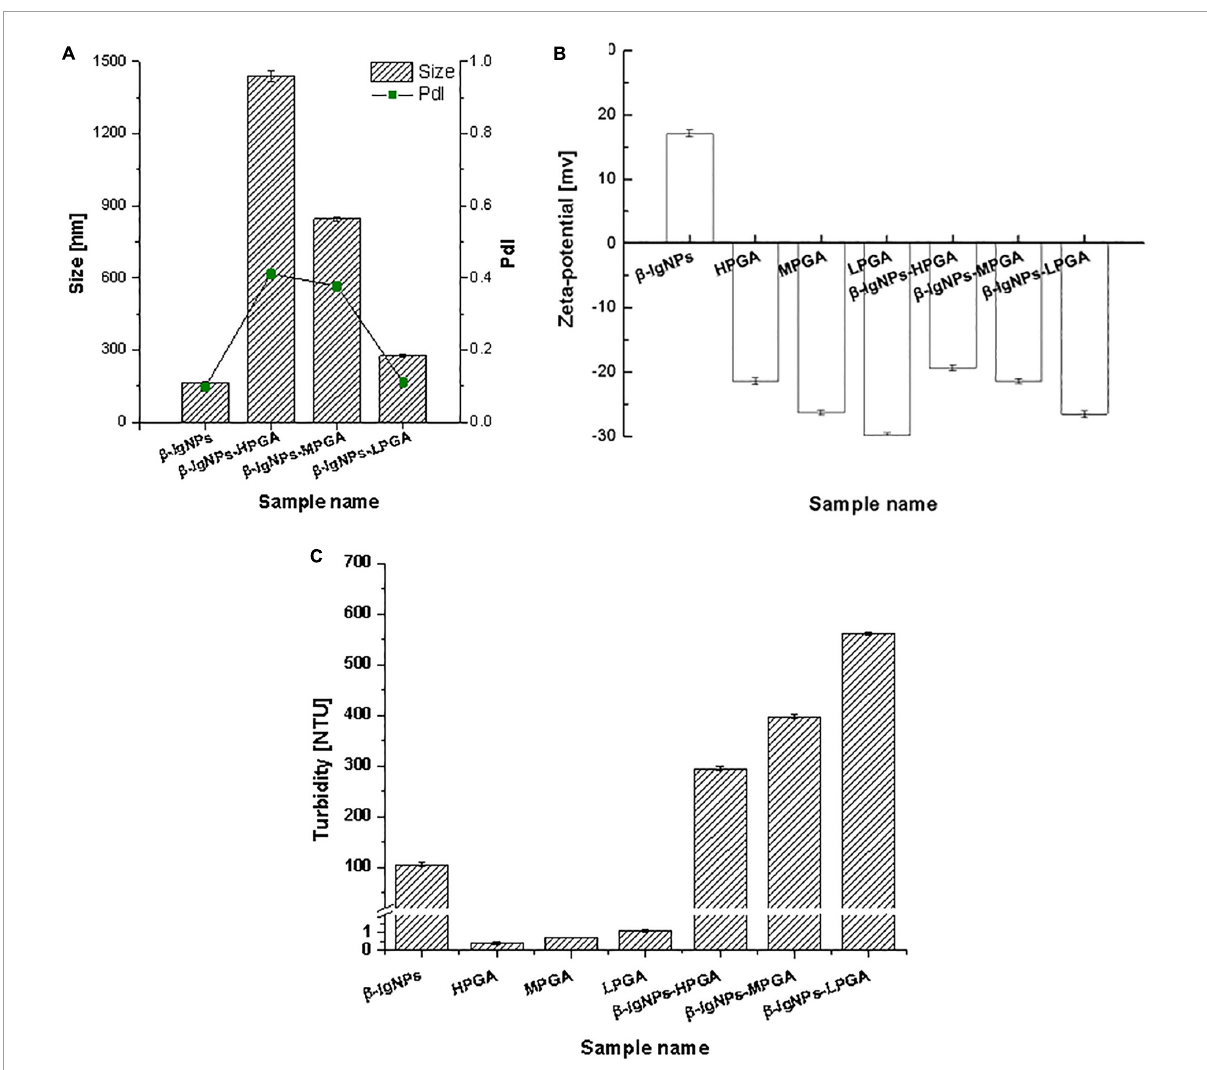
FIGURE4 Particle size, PDI (A) , zeta-potential (B) and turbidity (C) of β -lgNPs and PGA- β -lgNPs complexes with different M